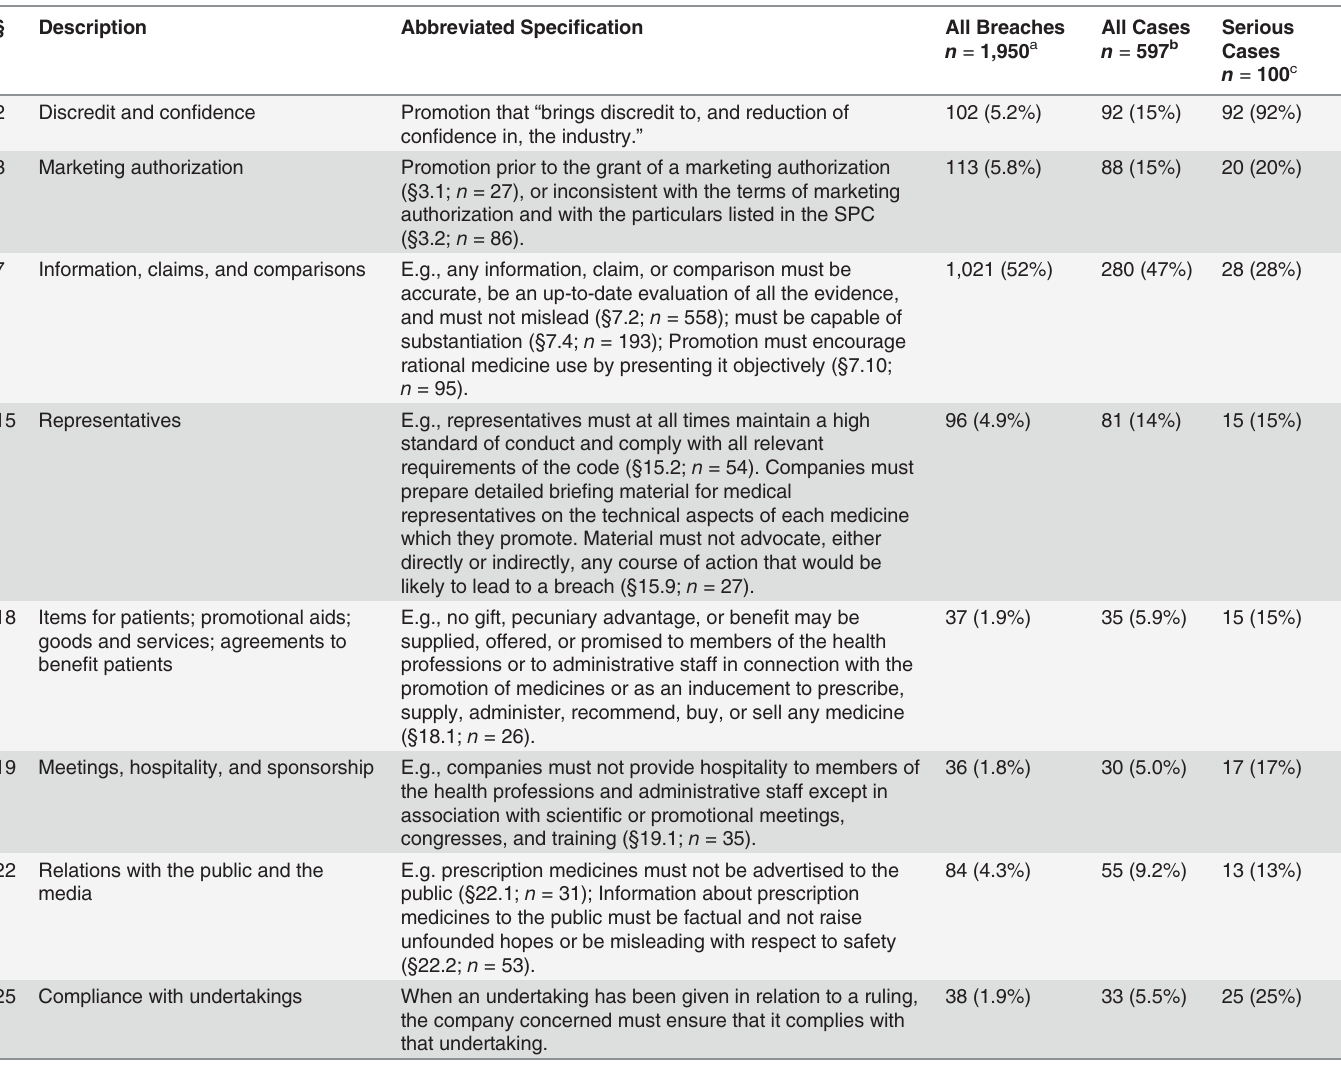
Table 3. UK rulings of breach of selected clauses 2004 –